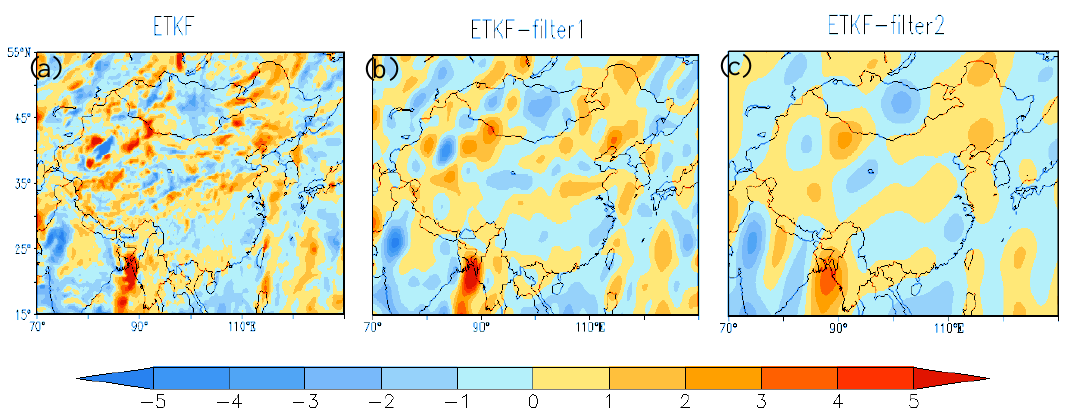
Figure 3. The horizontal distribution of the perturbation of the zonal wind: ( a ) ETKF, ( b ) ETKF-filter1, and ( c ) ETKF-filter2.